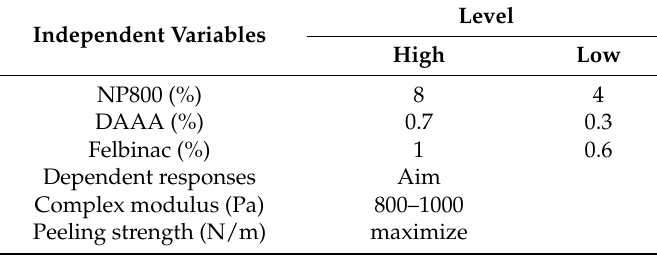
Table 1. The levels of independent variables and the range of dependent responses of felbinac cataplasms using Box–Behnken